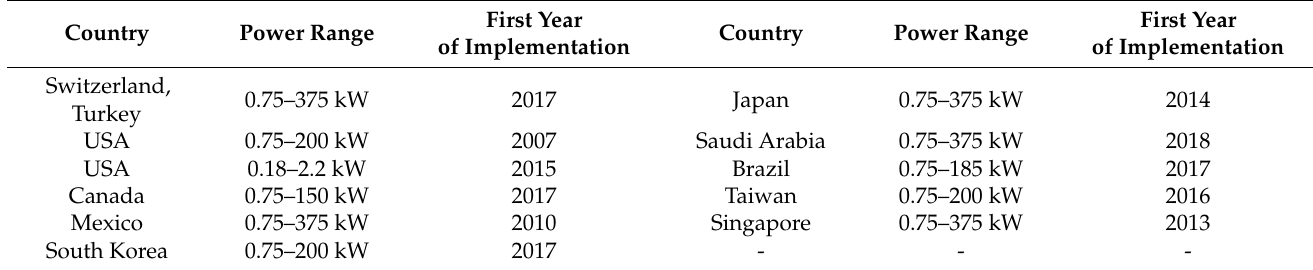
Table 1. Adopting national regulations for the mandatory IE3 class.